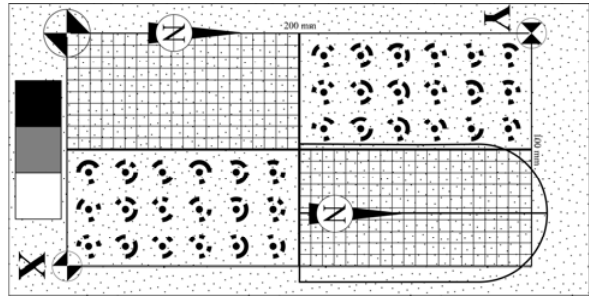
Figure 1. Ground control plate to orient local image series Placed horizontally and aligned to north the plate is positioned into the scene (Figure 2). Known distances between control marks on the plate, its horizontal alignment and North indicating by compass are used for scaling and orientation.